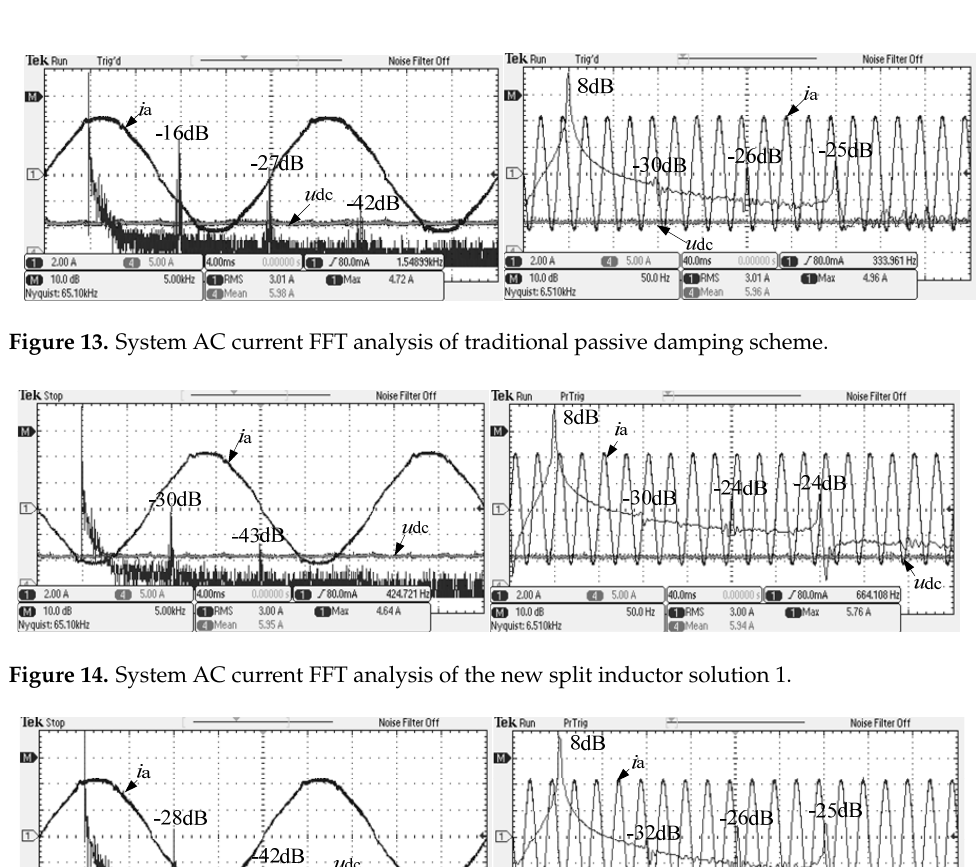
Figure 14. System AC current FFT analysis of the new split inductor solution 1.